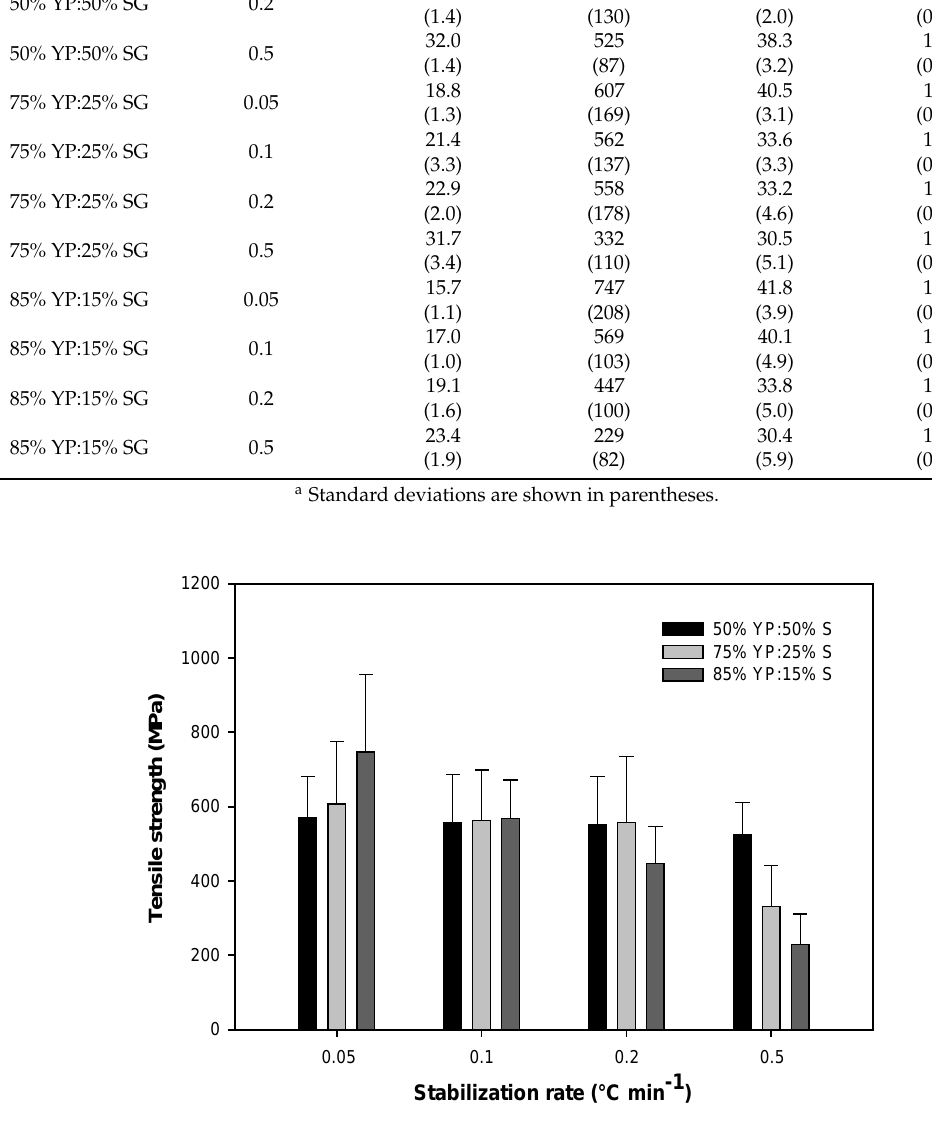
Figure 5. Effect of thermostabilization rate on tensile strength of carbon fibers made from different ratios of switchgrass and yellow polar lignin blends.